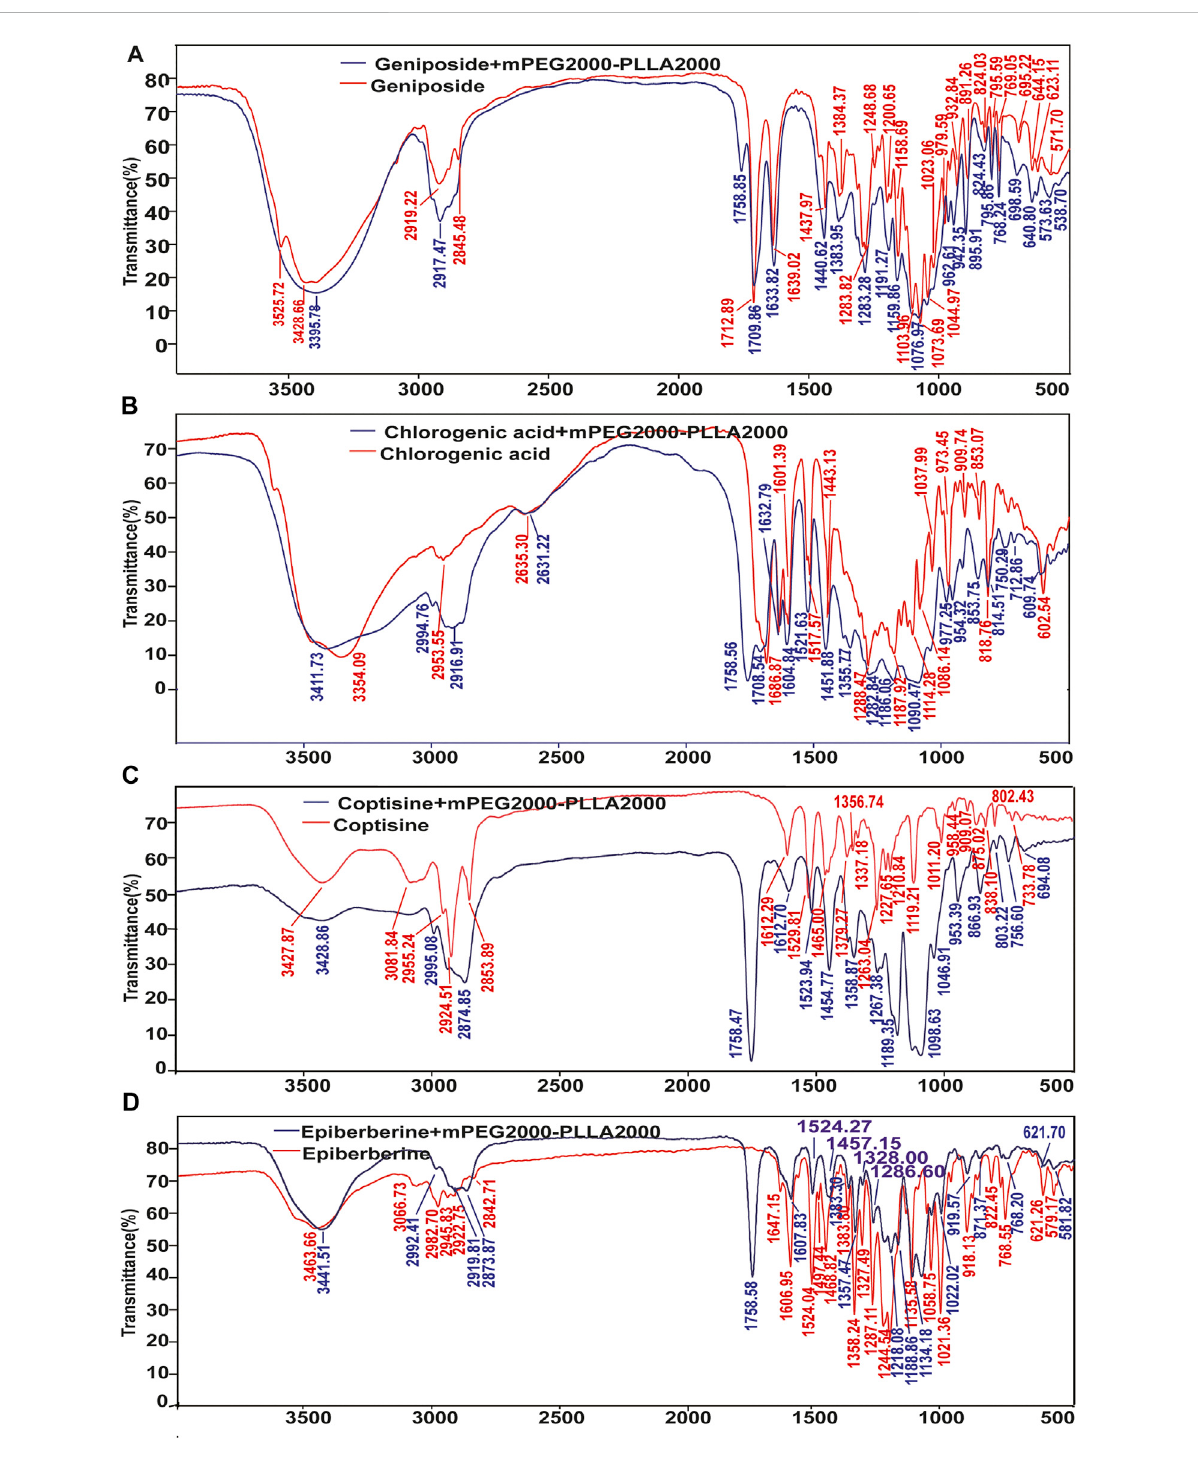
FIGURE 5 Results of IR analysis of the taste masking mechanism of mPEG2000-PLLA2000. (A) IR results of geniposide and geniposide + mPEG2000- PLLA2000, (B) IR results of chlorogenic acid and chlorogenic acid + mPEG2000-PLLA2000, (C) IR results of coptisine and coptisine + mPEG2000- PLLA2000, (D) IR results of epiberberine and epiberberine +